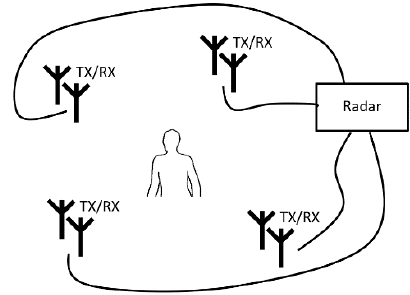
Figure 8. Graphical representation of the operating scenario described in [45].